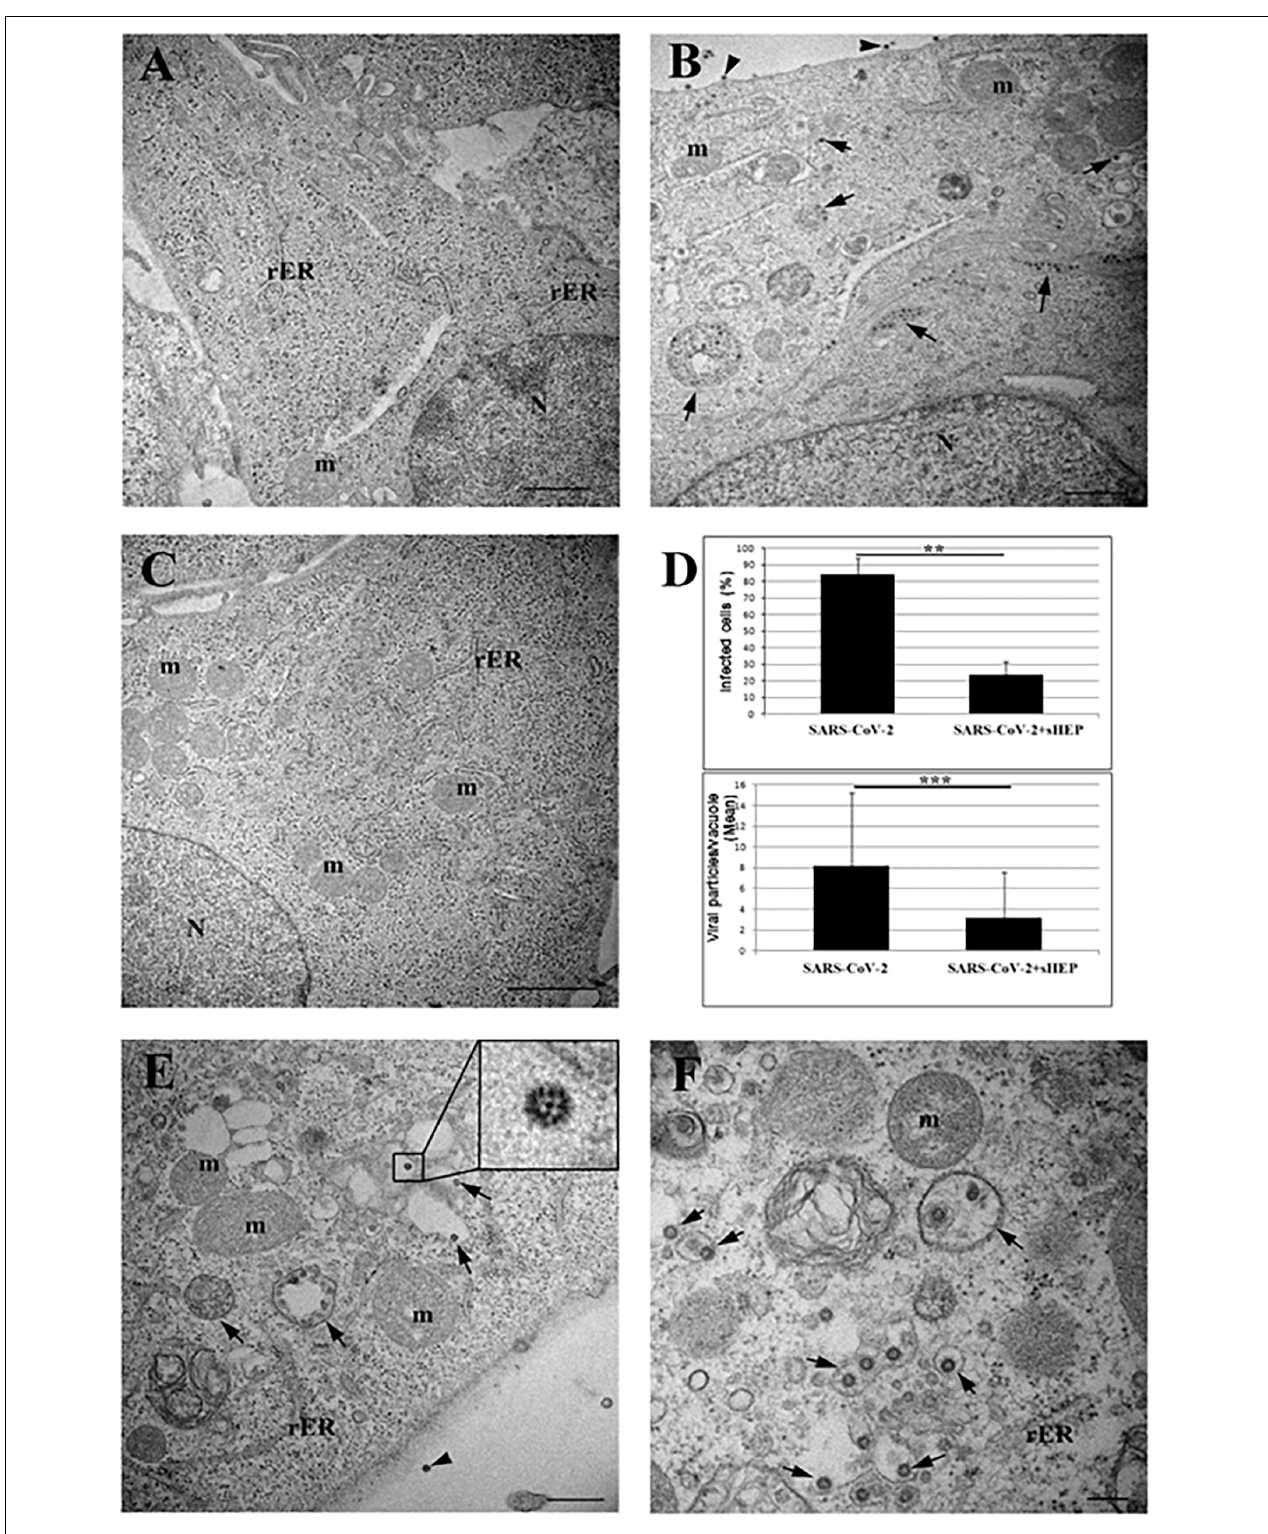
FIGURE 2 | Electron microscopy ultrastructure features of SARS-CoV-2-hfected VERO E6 cells treated with sHEP. Panel (A) the image shows the typical morphology of VERO E6 cells after 24 h culturing in presence of sHEP 25 µ g/mL. No signs of ultrastructural alterations were evident. Panel (B)